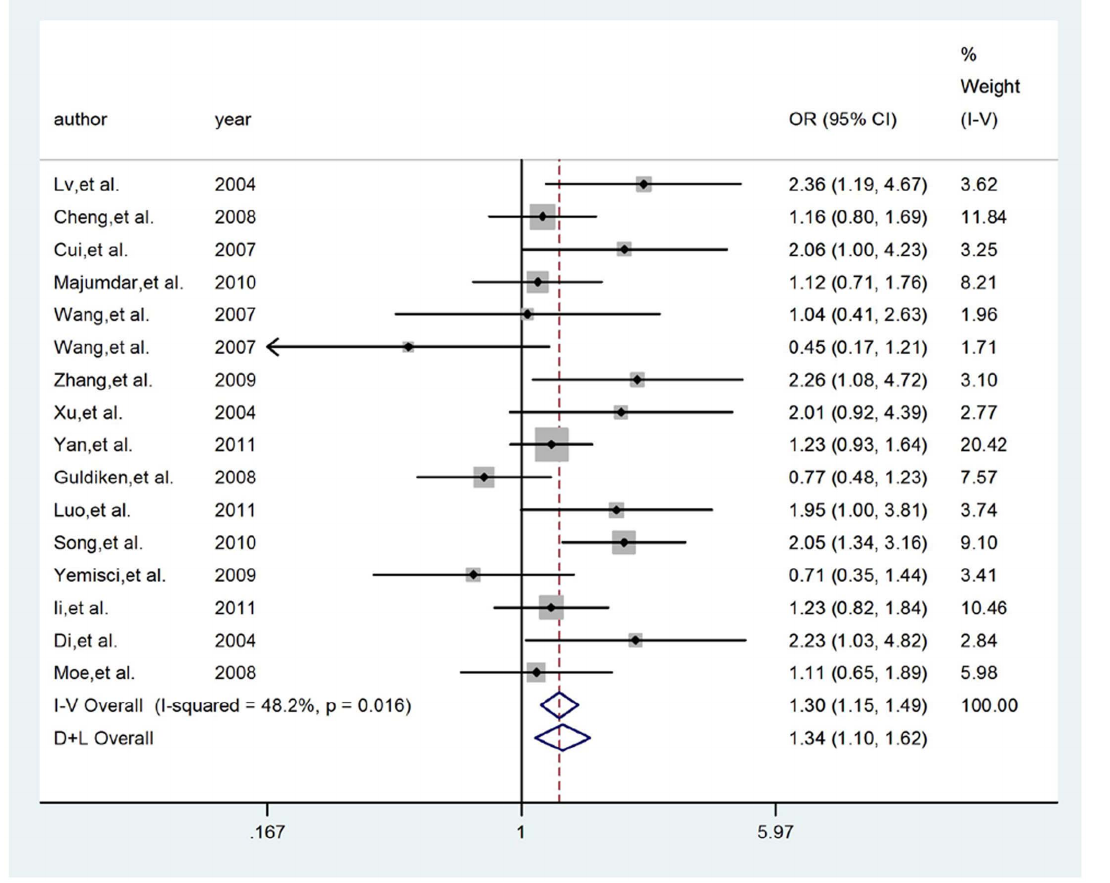
Figure 4. Meta-analysis for IS risk depending on the G894T polymorphism in the eNOS gene. Forest plots of relationship between eNOS gene G894T polymorphism and IS risk in dominant model in Asian. White diamond denotes the pooled OR. Black squares indicate the OR in each study, with square sizes inversely proportional to the standard error of the OR. Horizontal lines represent 95% CIs.